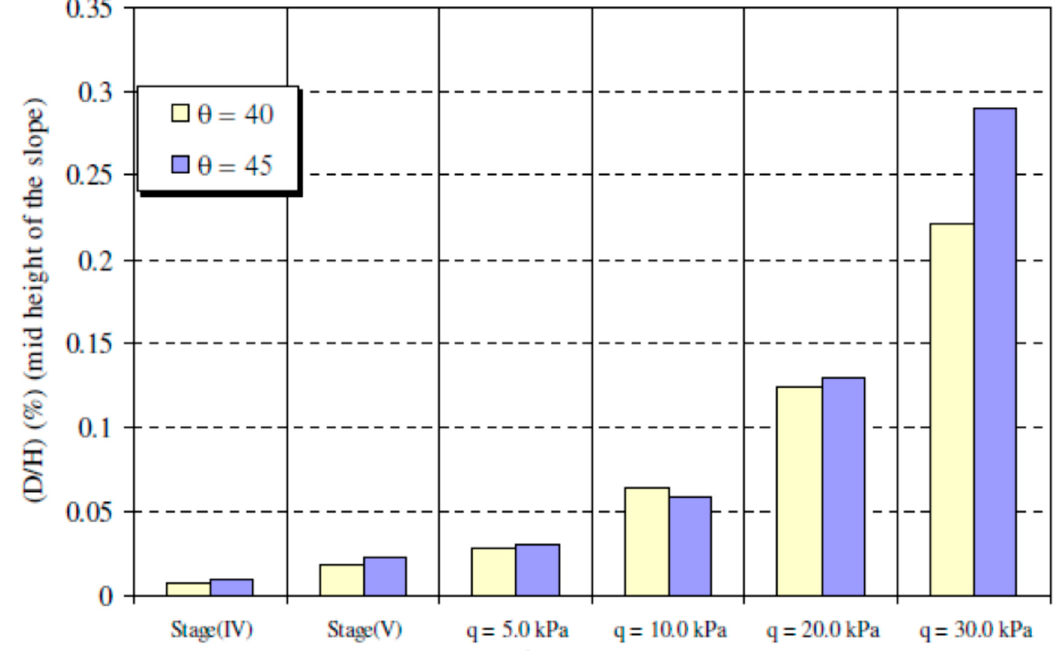
Figure 12. Influence of slope inclination on the horizontal movement at mid-height of slope.